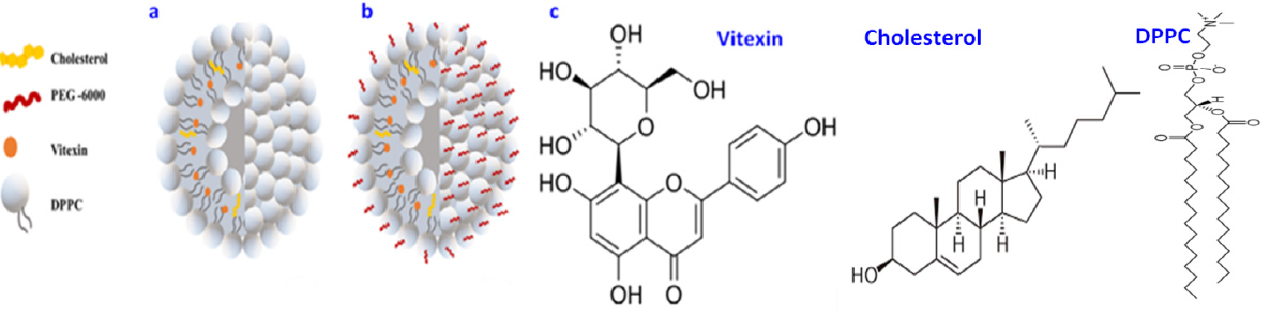
Figure 1. Pictorial depiction of ( a ) Vitexin liposomes (VLPs) ( b ) polyethylene glycol coated vitexin liposomes (PEG-VLPs) ( c ) Structure of Vitexin, Cholesterol, and Dipalmitoyl phosphatidylcholine (DPPC).